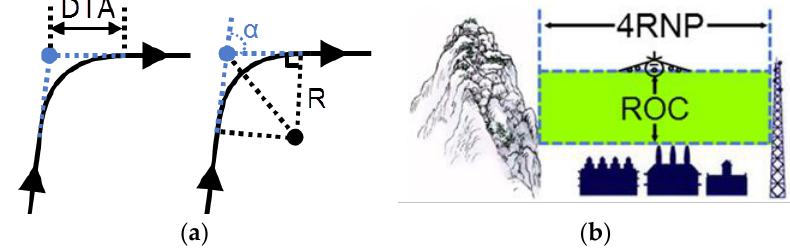
Figure 11. ( a ) Distance of turn anticipation model; ( b ) Profile view for RNP segment width.